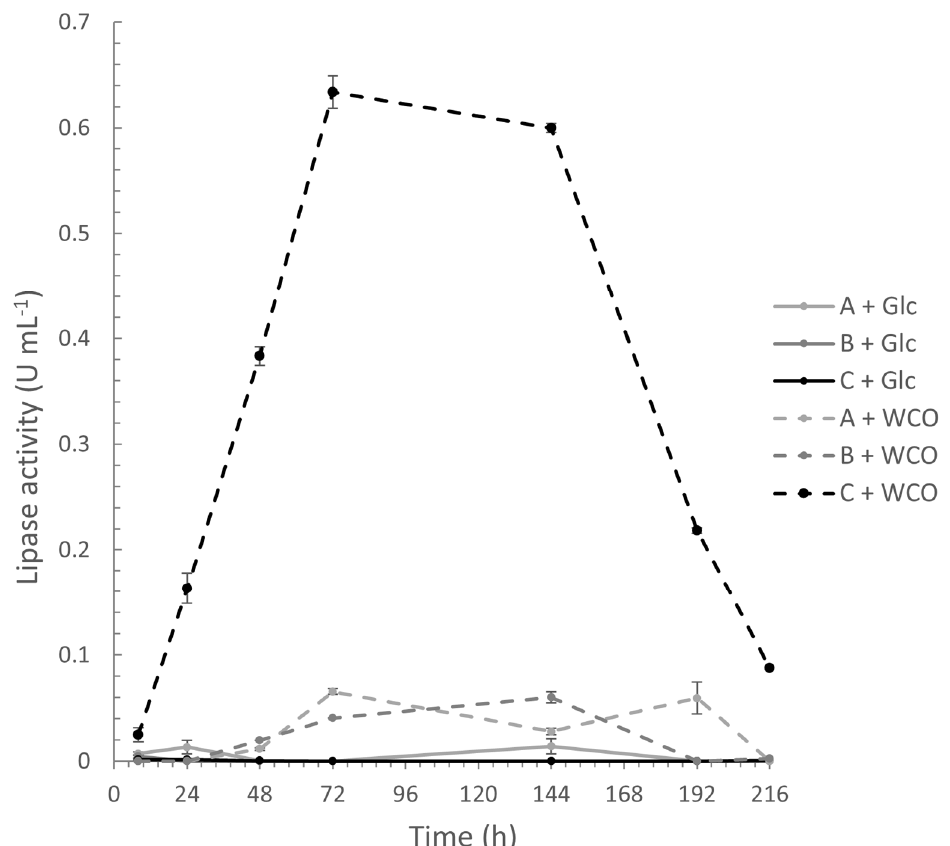
Figure 2. Lipase activity over time for small-scale cultures during 216 h containing either glucose or WCO as a carbon source. Data are mean values of three different measurements, and bars represent standard deviations.